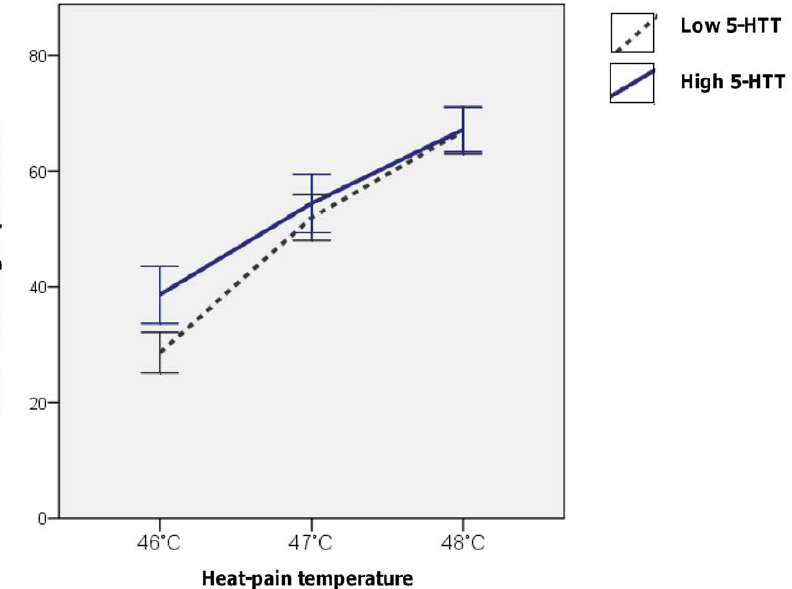
Figure 4. Interaction between pain-ratings for suprathreshold noxious heat and genotype. Mean VAS-ratings for suprathreshold noxious heat, applied to the right ventral forearm, are shown for the low 5-HTT-expressing and high 5-HTT-expressing genotype groups, respectively. The interaction between temperature level and genotype on the VAS-rating was significant [F(1.60, 65.51)=4.10, p=0.03].